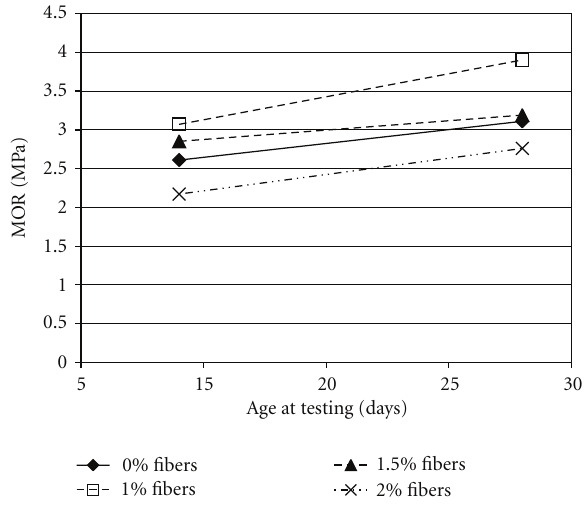
Figure 8: E ff ect of increasing percentages of recycled polymer fiber on the MOR of a mortar with ten percent type I/II